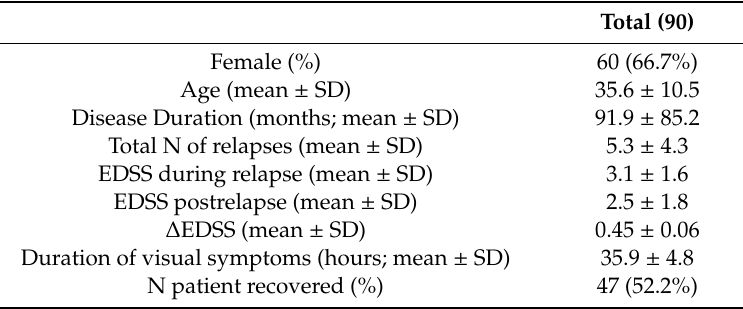
Table 1. Demographic and clinical characteristics of ON MS patients.